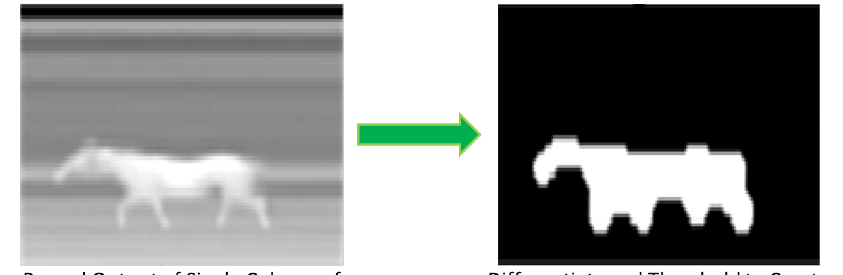
Figure 17. Block diagram showing the process of simulation